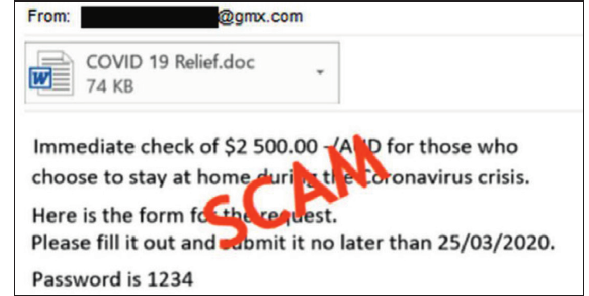
Figure 14: International scam invites people as casual employees or volunteers to help the “Coronavirus Relief Fund”